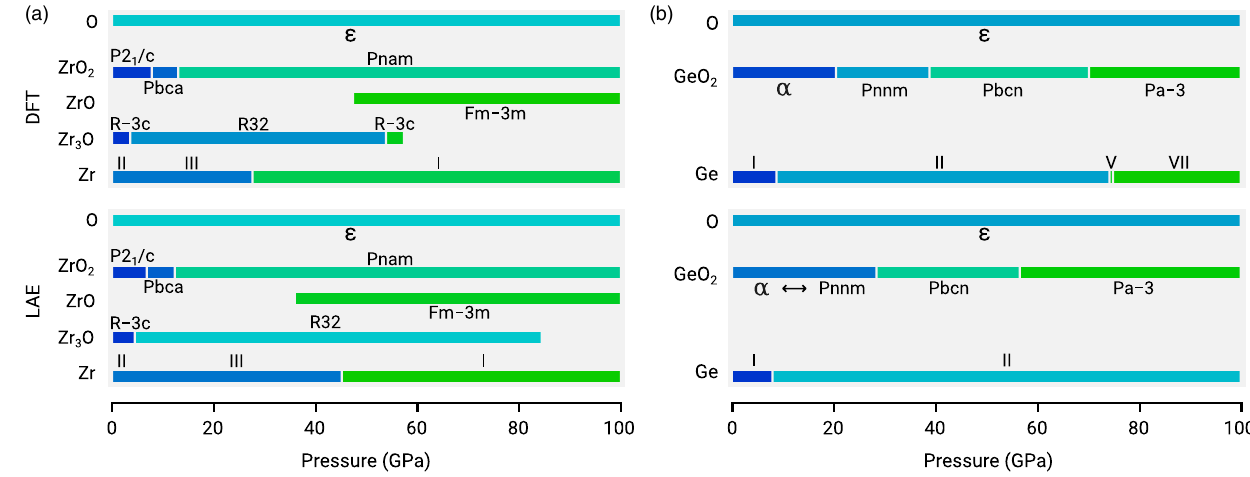
FIG. 4. Comparison between the explicitly computed phase diagrams and the ones calculated using the LAE model for two oxide systems. Panels (a) and (b) correspond to the Zr – O and the Ge – O systems, respectively. Explicitly calculated transition pressures using DFT are denoted with “ DFT ” (top bar), and results based on the LAE are denoted with “ LAE ” (bottom bar). The arrow denotes the displacive phase